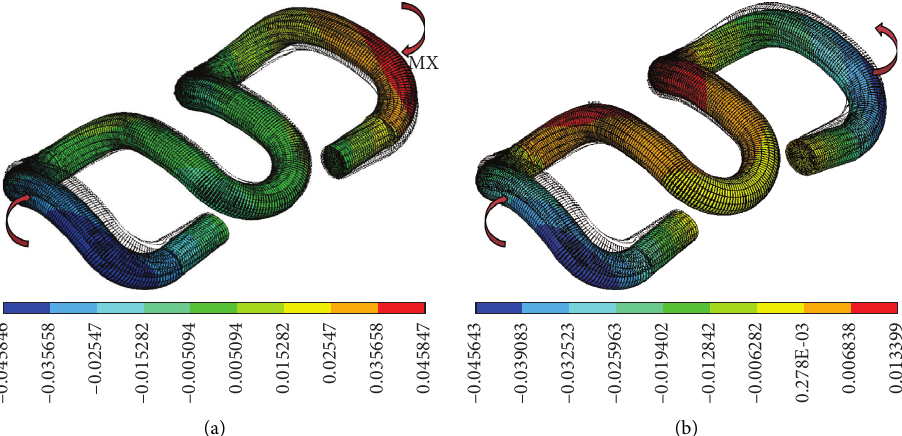
Figure 4: Vibration modes of elastic rail clips under normal installation: (a) first-order vibration mode; (b) second-order vibration mode.